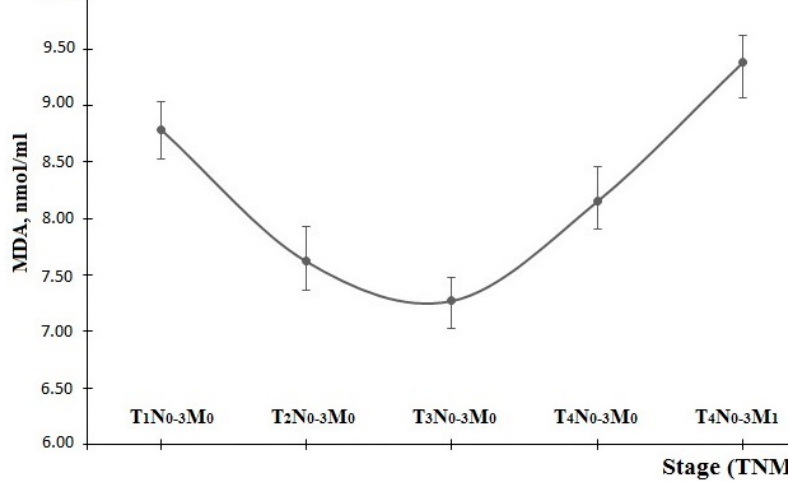
Figure 5. Dynamics of MDA level, depending on disease stage.